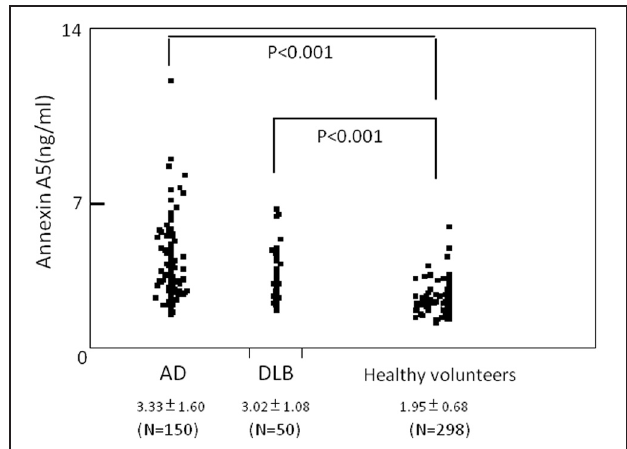
FIGURE 1 | Comparison of plasma levels of annexin A5 in AD, DLB patients, and healthy volunteers (control). For quantitative analysis, we established a chemiluminescent enzyme immunoassay system with monoclonal antibodies against human annexin A5 and measured human plasma annexin A5. Dot blot is shown. Each point represents the plasma annexin A5 concentration of individual. AD, Alzheimer’s disease; DLB, dementia with Lewy